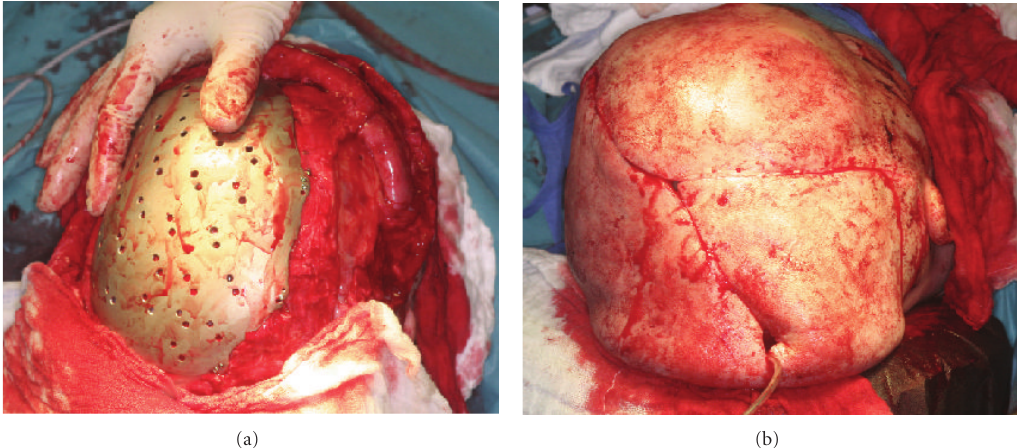
Figure 4: (a) Shows the “in situ” titanium cranioplasty. Note the fit and screw fixation to the defect margins. (b) Postoperative view after tension-free skin closure.